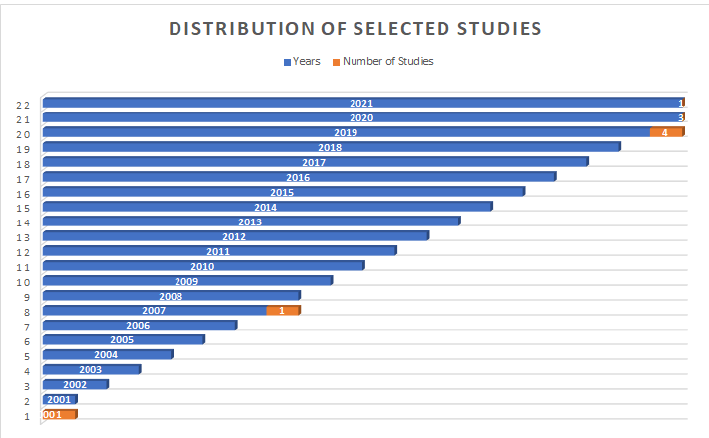
Figure 2. Distribution of Selected Studies (Year).